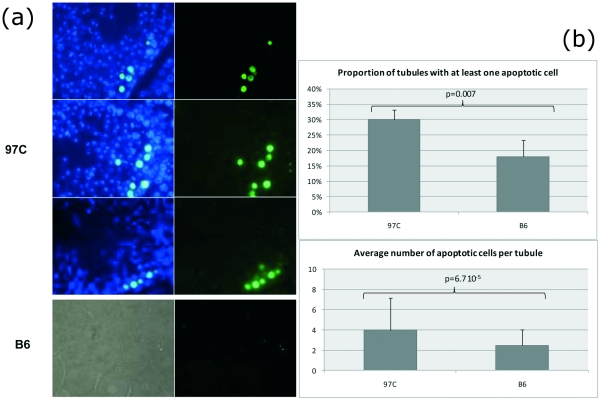
Apoptosis in the seminiferous tubules of adult 97 C mice.The apoptotic cells were studied for their localization (a) and their number (b) in B6 and 97 C testes using the TUNEL assay. (a) DNA strand breaks of the apoptotic cells were revealed by fluorescein-dUTP (green fluorescence) and the sections were counter-colored by DAPI (blue fluorescence). Clusters of TUNEL positive cells were observed in tubule sections of 97 C testes, principally spermatocytes at the stages VI–VII of the spermatogenesis (objective ×100). In B6 testis sections, the apoptotic cells were scattered in some tubules (left: transmission light; right: epifluorescence; objective ×20). (b) Percentage of sections containing at least one apoptotic cell was significantly higher in 97 C testis when compared to B6 (30% and 18% respectively; chi square test p<0.007). In these positive tubules, the number of apoptotic cells per tubule (mean ± SD) was significantly higher in 97 C testis than in B6's (3.98±3.15 and 2.48±1.54, respectively; p<6.7 10−5).